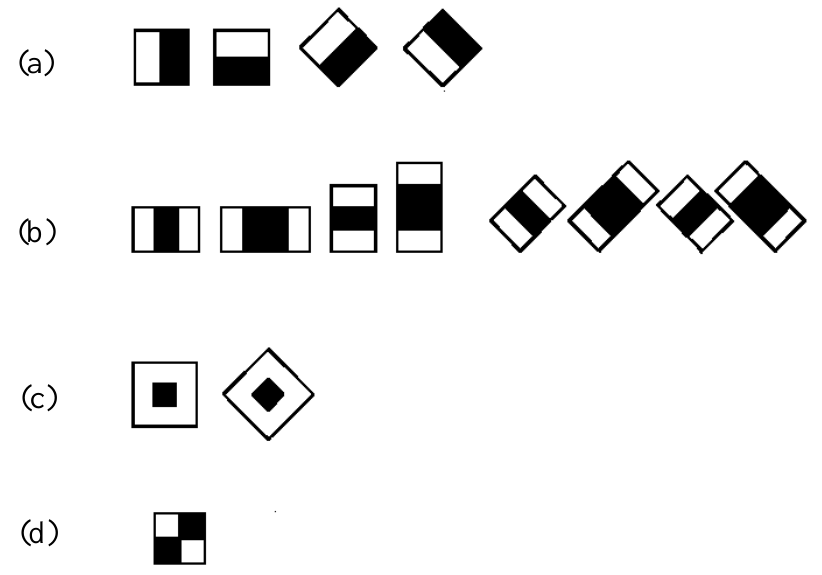
Figure 2. Extended Haar-like features: ( a ) edge features, ( b ) line features, ( c ) center-surrounded features and ( d ) a special diagonal line